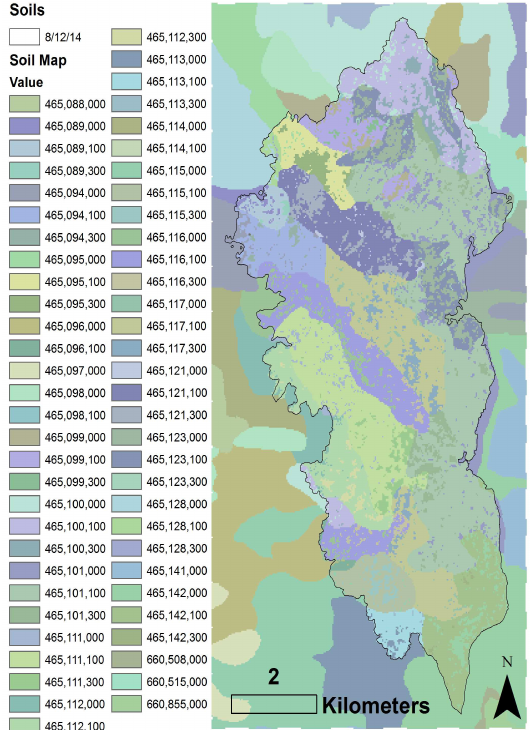
Figure 4. A soils map generated by the database depicting soil files modified by the burned French Fire land cover layer. To facilitate modeling the WEPP soil parameter and linkage files are also provided by the online